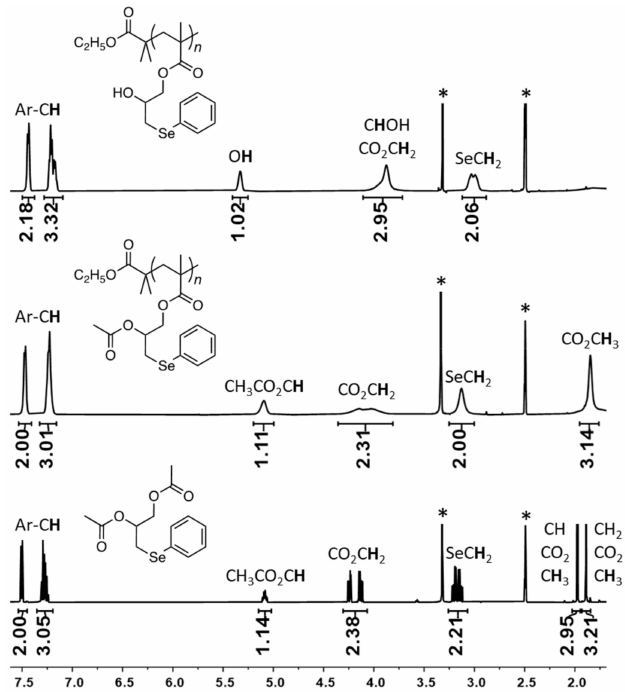
Figure 3. 1 H-NMR (DMSO- d 6 ) of polymer 3 before ( top ) and after ( middle ) acetylation. The bottom shows a model compound of known regiochemistry prepared through selenium–halide reaction between bromopropane diol and benzeneselenol followed by acetylation [2]. The residual